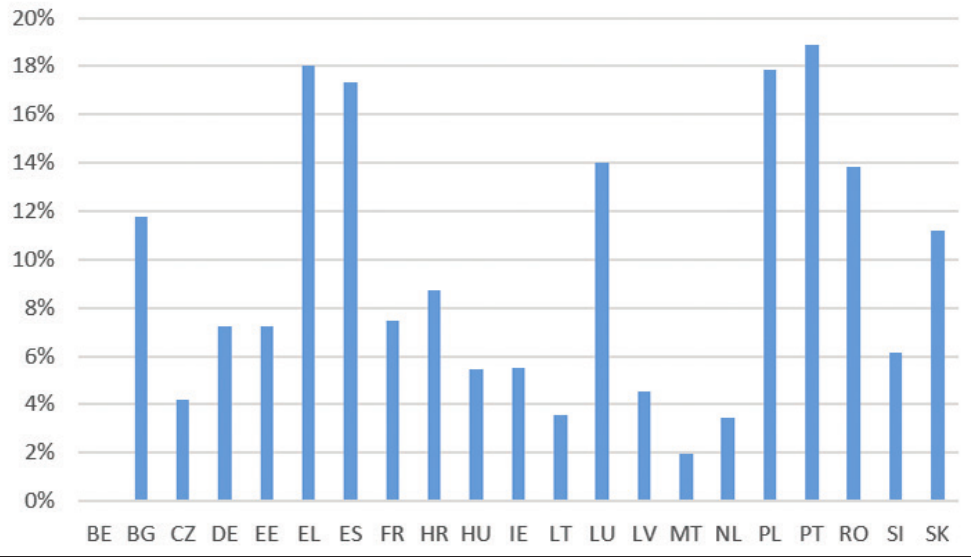
Notes : EUROMOD simulations for 2019. The graph shows the share of workers earning from 80% to 105% of the MW in the baseline. Countries are sorted alphabetically. BE, Belgium; BG, Bulgaria; CZ, Czech Republic; DE, Germany; EE, Estonia; EL, Greece; ES, Spain; FR, France; HR, Croatia; HU, Hungary; IE, Republic of Ireland; LT, Lithuania; LU, Luxembourg; LV, Latvia; MS, Member States; MT, Malta; MW, minimum wage; NL, The Netherlands; PL, Poland; PT, Portugal; RO, Romania; SI, Slovenia; SK, Slovakia; SMW, statutory